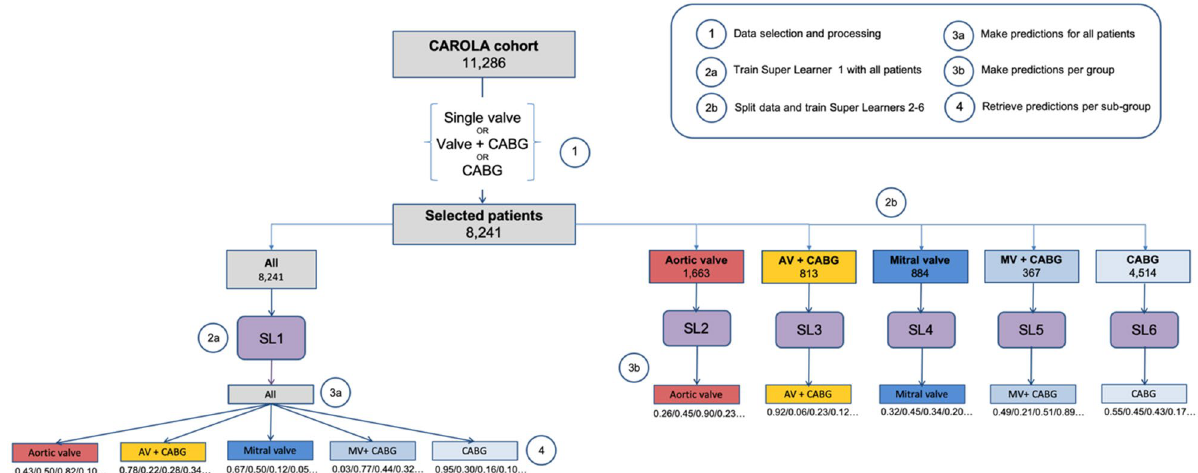
Figure 6. Diagram of the steps involved in data analysis: data split, algorithm training, and outcome prediction using different Super Learner ensembles. On the left, the process of training the single Super Learner on data of the whole cohort (n = 8241), obtaining the pooled predicted probabilities, and retrieving the group-specific probabilities to calculate the performance measures for each type of operation. On the right, the process of splitting the data into five groups, one per operation type, and training a different super learner on data from one type of operation only. SL super learner, AV aortic valve, MV mitral valve, CABG coronary artery bypass